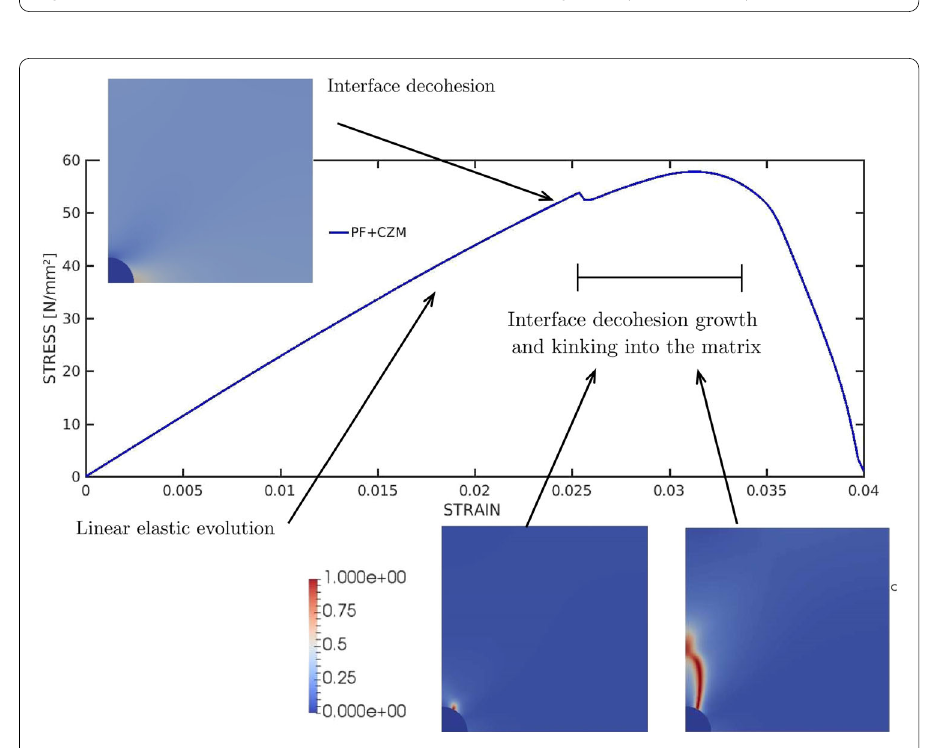
Fig. 19 Micromechanics of fibre reinforced composite materials: stress–strain evolution curve and damage pattern at different stages of the